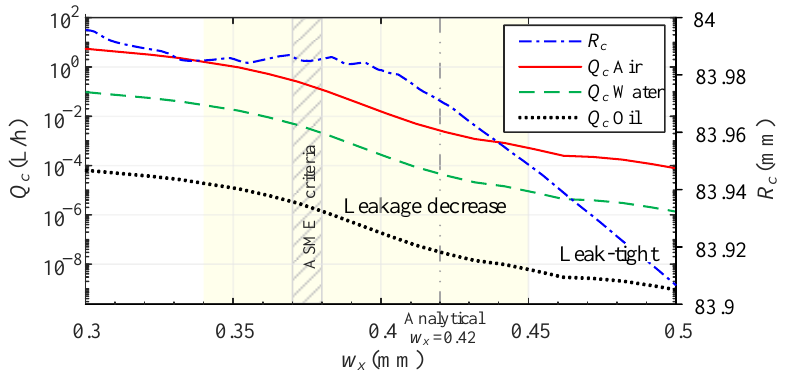
Figure 17. Leakage ratios as a function of base deflection.